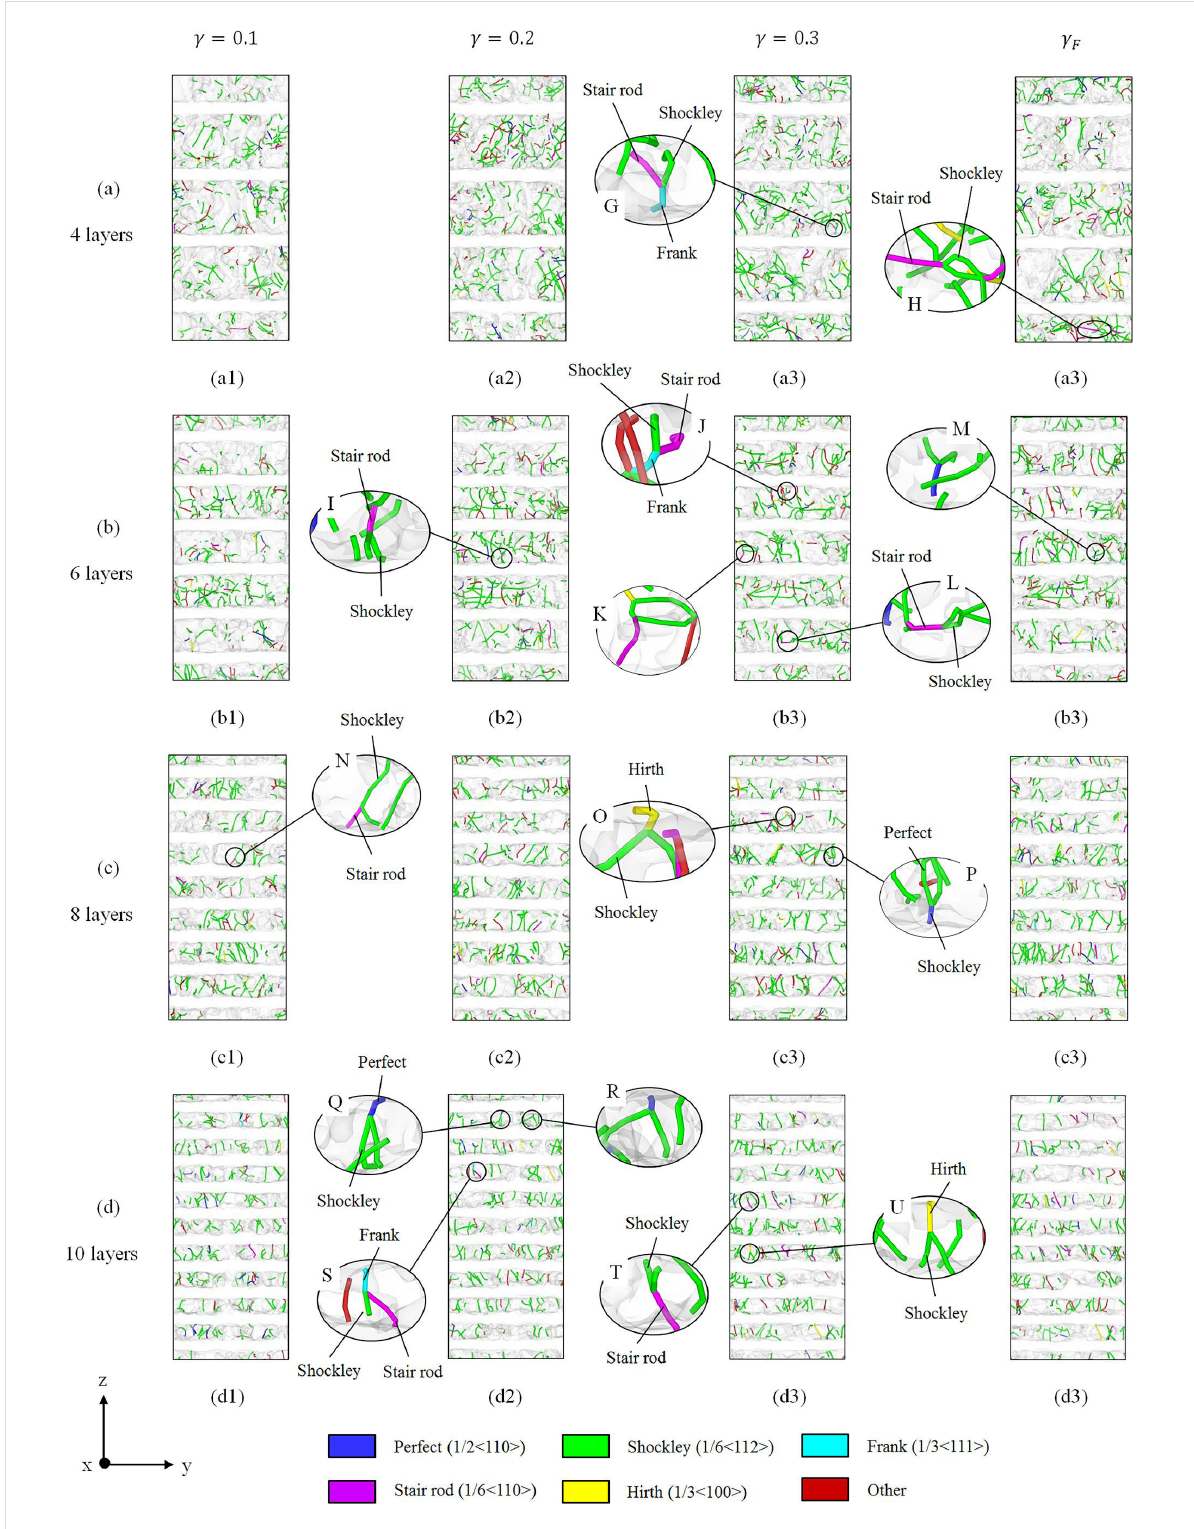
Figure 13: The DXA analysis of GPCuNL composites with different repeat layer spacings at 300 K. The magnified images (M), (P), (Q), and (R) eluci- date the formation of perfect dislocations from two Shockley partial dislocations. The magnified images (H), (I), (K), (L), (N), and (T) show the relation- ship between stair-rod dislocations and Shockley dislocations. The magnified images (O) and (U) show the formation of a Hirth dislocation from two Shockley dislocations with vertical Burgers